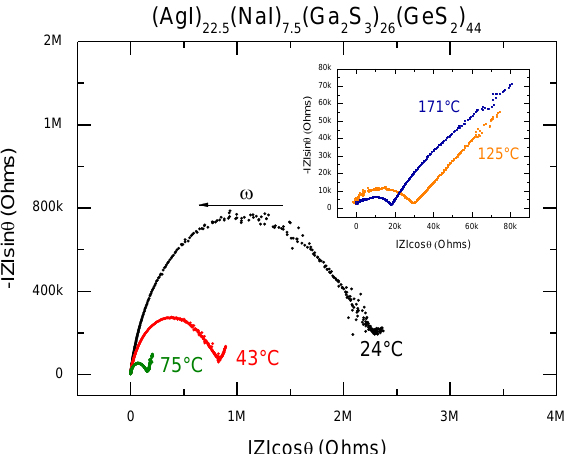
Figure 4. Cole–Cole impedance plots for the (AgI) 22.5 (NaI) 7.5 (Ga 2 S 3 ) 26 (GeS 2 ) 44 glass sample at different temperatures.